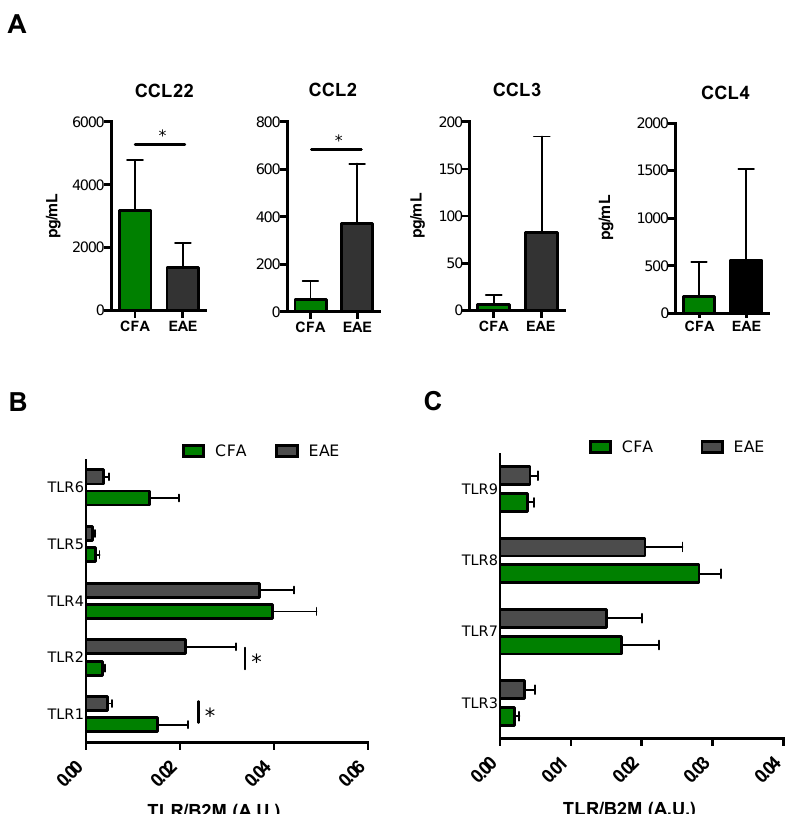
Figure 6. Expression of cytokines/chemokines and TLRs in M2 obtained from CFA and EAE mice. ( A ) ELISA of chemokines (CCL2, CCL3, CCL4, and CCL22) in supernatants of M2 macrophages. Data are reported as pg/mL and represent eight independent experiments means ± SEM. * p < 0.05 ( B , C ) qRT-PCR analysis of the expression of both bacterial (TLR1, TLR2, TLR4, TLR5, TLR6) ( B ) and viral (TLR3, TLR7, TLR8, TLR9) ( C ) Toll-like receptors in M2 macrophages. Cycling threshold values are normalized to those of mRNA encodin g β2 -microglobulin, and data are normalized to the maximum value obtained for each donor. Data are expressed as arbitrary units (A.U.) and are shown as means ± SEM of eight independent experiments each in duplicate. * p < 0.05.